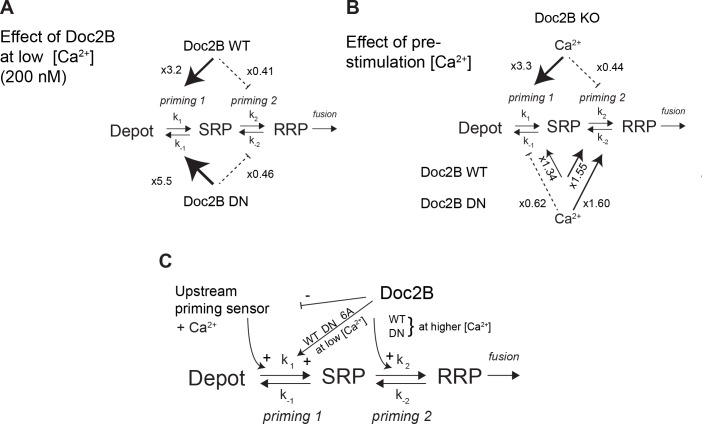
Dissecting the effect of Doc2B on two sequential priming steps.(A) Chromaffin cells feature two sequential priming steps: priming 1, which recruits vesicles to the SRP, and priming 2, which recruits them to the RRP. At equilibrium, the overall propensity for forward priming is k1[Depot]/k-1 and k2/k-2, respectively (see Materials and methods). Shown is the multiplicative effect of expressing Doc2B WT and DN mutant on priming 1 and priming 2 propensities at low [Ca2+]. Both proteins stimulate priming 1, but inhibit priming 2. It has been proposed that SRP-vesicles fuse directly (Voets, 2000), or, as indicated here, that they mature to RRP-vesicles before they fuse (Walter et al., 2013); the experiments we present here do not distinguish between two possibilities, but see (Walter et al., 2013). (B) The effect of increasing [Ca2+] from 200 to ~ 800 nM, in the Doc2B KO, or after expression of Doc2B WT or DN. Ca2+ stimulates priming 1 strongly in the Doc2B KO, but inhibits priming 2, whereas with Doc2B, priming 2 is stimulated by Ca2+. (C) Overall model for the effect of Doc2B on priming 1 and priming 2. Doc2B (and the DN and 6A mutants) stimulates priming 1, but also occludes its Ca2+-dependence, presumably by inhibiting or competing with another Ca2+-dependent priming protein (upstream priming sensor) that normally acts at priming 1. Ca2+ increases the effect of Doc2B on priming 2; this effect is seen also in the DN-mutant, but not in the 6A-mutant; therefore, it depends on Ca2+ binding to the C2B-domain.10.7554/eLife.27000.014Figure 10—source data 1.Values for pool sizes and priming 1 and priming 2 propensity from experiments in Doc2B KO, and after overexpression of Doc2B WT and DN-mutant (see also Figure 4).The propensity for upstream priming, priming 1, k1[Depot]/k-1, is simply equal to the slow burst (SRP) size, whereas the propensity for priming 2, k2/k-2, is equal to the ratio between fast and slow burst (RRP/SRP). To determine the effect of increasing basal [Ca2+] from ~200 nM to ~800 nM, we calculated the ratio of the propensities between Ca2+ concentrations for a given genotype (two columns on the right). To calculate the effect of expressing Doc2B and the Doc2B DN mutant at ~200 nM [Ca2+] we formed the ratio of the propensities between expressed and KO cells for a given [Ca2+] (six bottom rows).